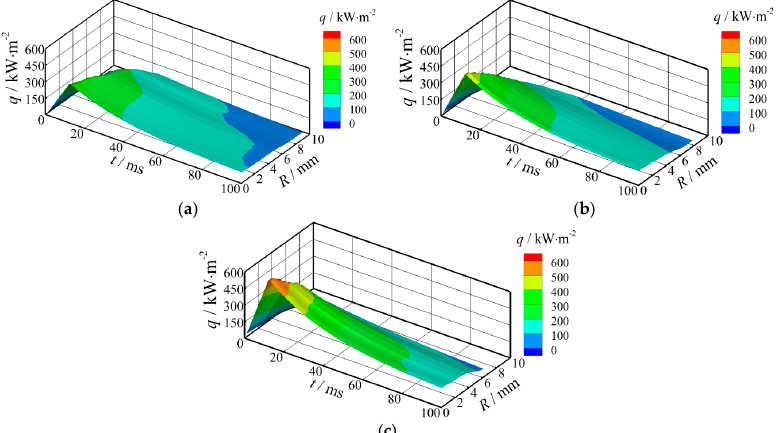
Figure 14. Spatial and temporal distributions of surface heat flux under optimum spray distance: ( a ) R134a, ( b ) R404A and ( c ) R32.